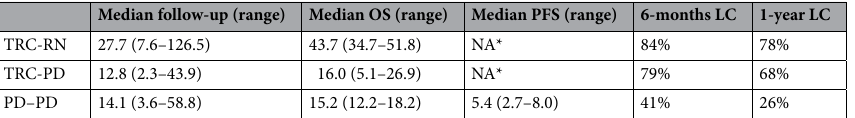
Table 2. Summary of clinical outcomes after surgical resection to GKS-treated metastases. LC Local control, NA Not applicable, OS Overall survival, PFS Progression free survival. *Median PFS of TRC-RN and TRC-PD were not applicable because less than 50% of patients were confirmed with progressive disease after surgical resection during the follow-up